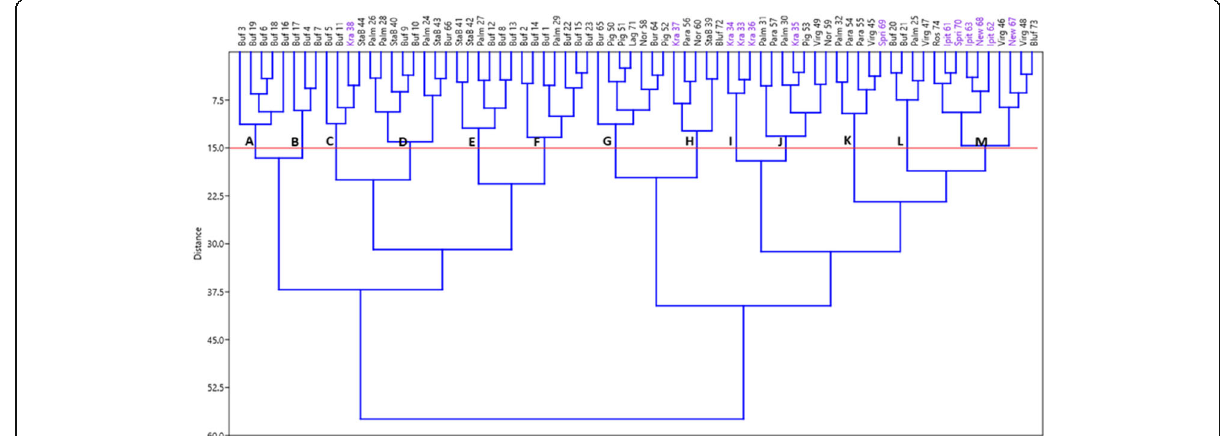
Fig. 2 Dendrogram showing the results of cluster analysis based on Ward-Euclidean for the species occurring in the plots. Community clusters delimited at 15% dissimilarity are labelled with letters from A to M, and the red line cuts clusters dominated by similar species. Codes on x -axis refer to all plot numbers of patches where the purple are from scarp forest and black from lowland forests